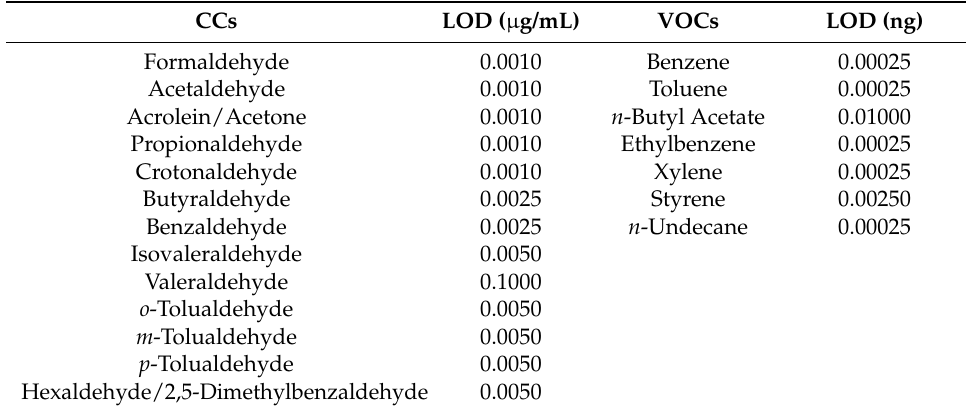
Table 2. The limit of detection (LOD) for VOCs and CCs.